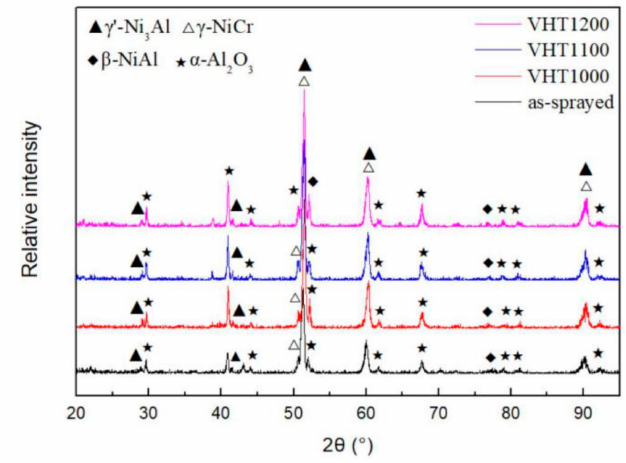
Figure 10. XRD results of the as-sprayed and heat-treated coatings after the oxidation